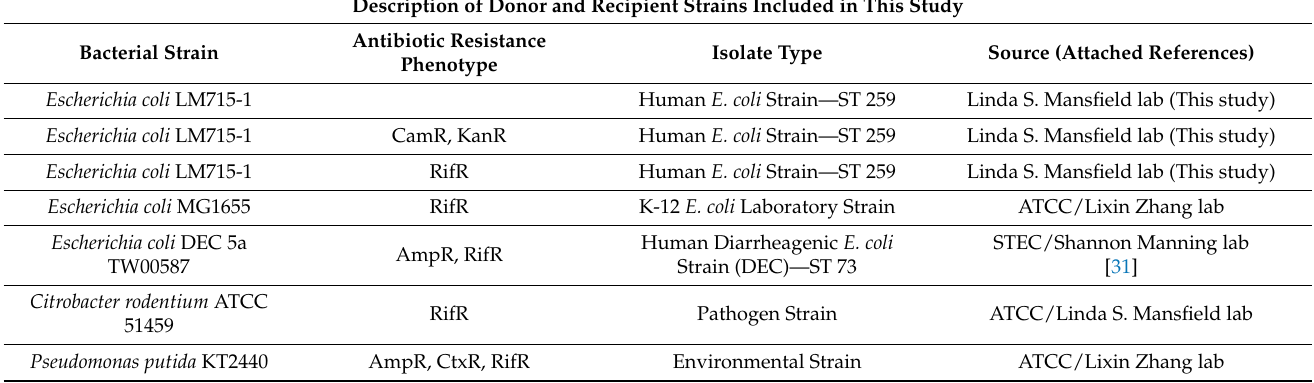
Table 1. Bacterial strains with their antibiotic resistance profiles and isolation